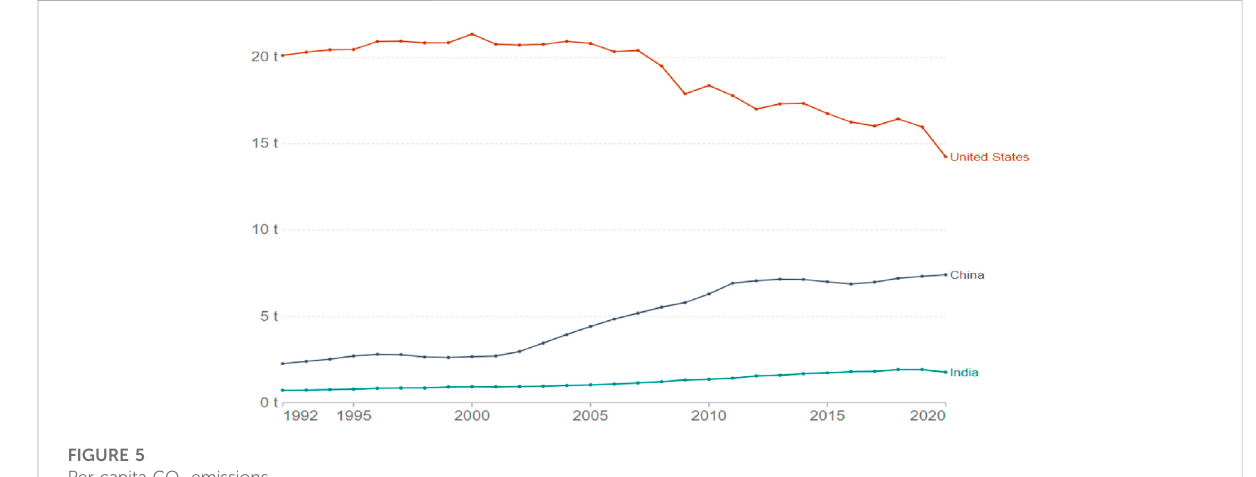
FIGURE 5 Per capita CO ₂ emissions.